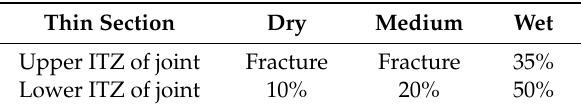
Table 8. Contact in/on the brick and mortar interface.